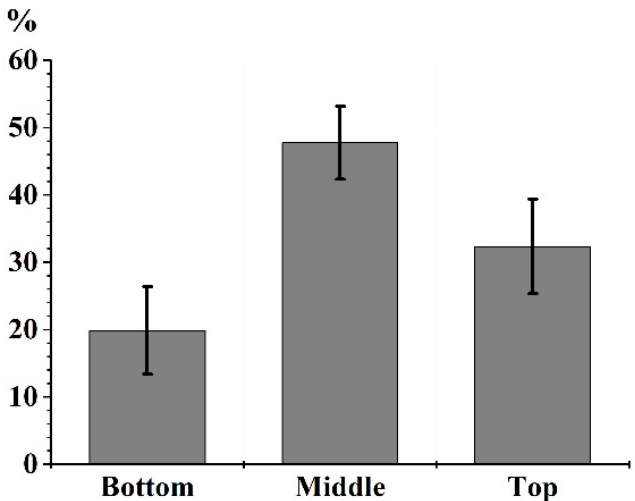
Figure 4. Vertical leaf area ( LA ) distribution based on the mean LA of the 29 Moso bamboo crowns. The error bars represent the percentage of mean ± standard deviation.